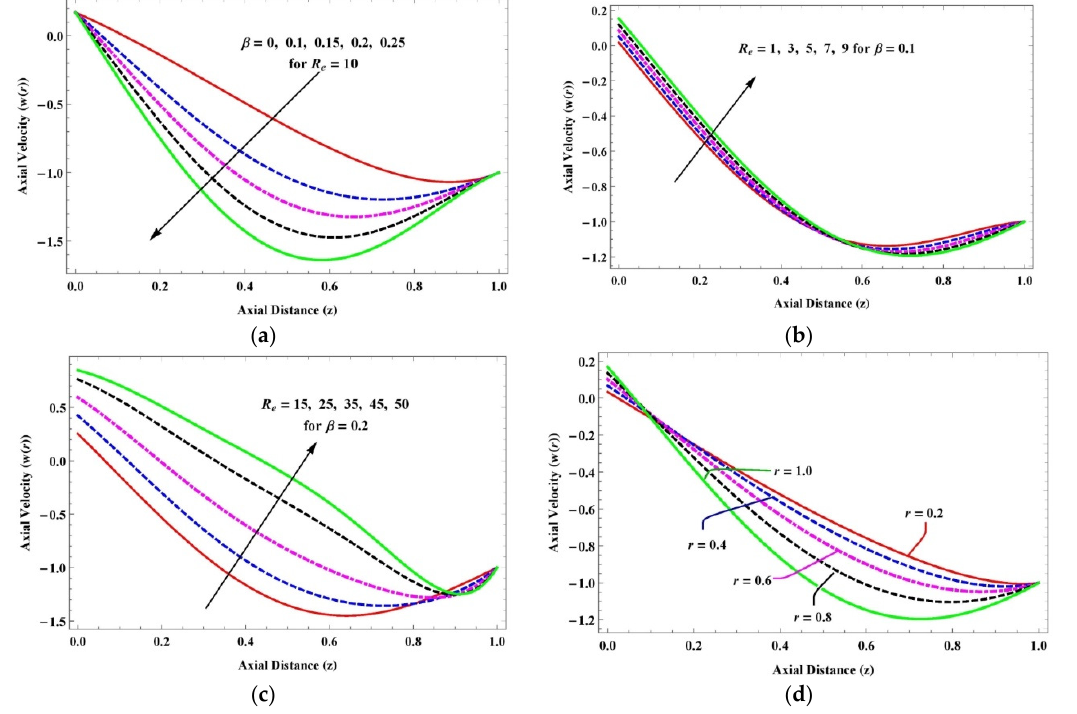
Figure 8. ( a – d ) Variation in axial velocity due to ( a ) rise in β with R e = 10; ( b ) rise with small R e ; ( c ) rise with large R e ; ( d ) variation in radial ( r ) points with R e = 10.